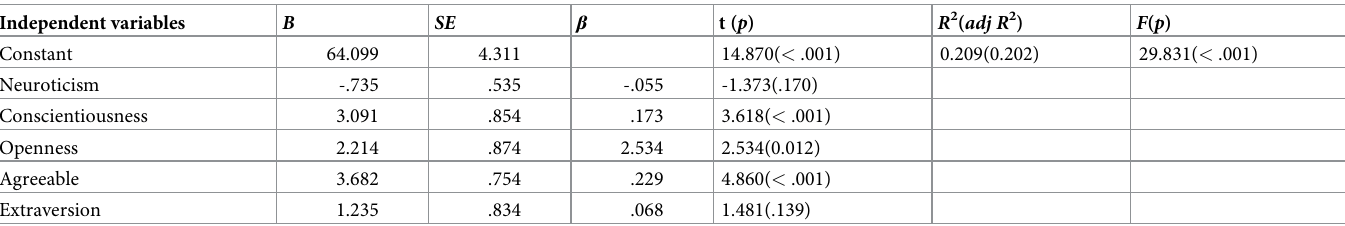
Table 5. Regression analysis of death coping self-efficacy in